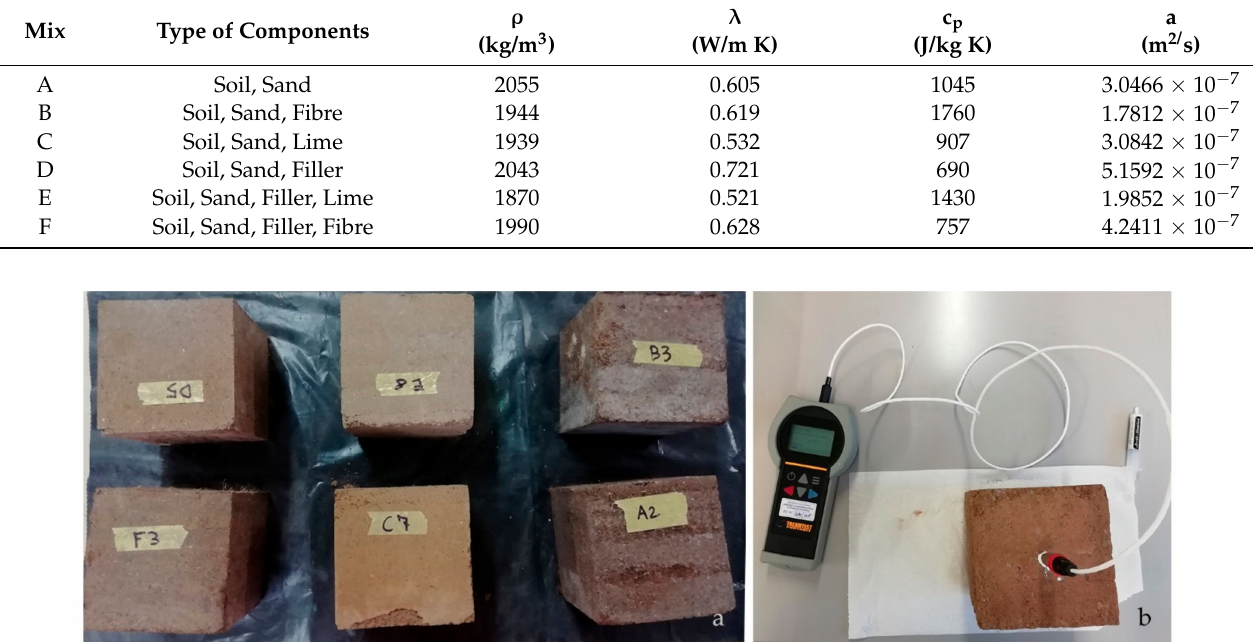
Table 6. Thermophysical properties of the rammed earth materials developed with the Guglielmino Soc. Coop.